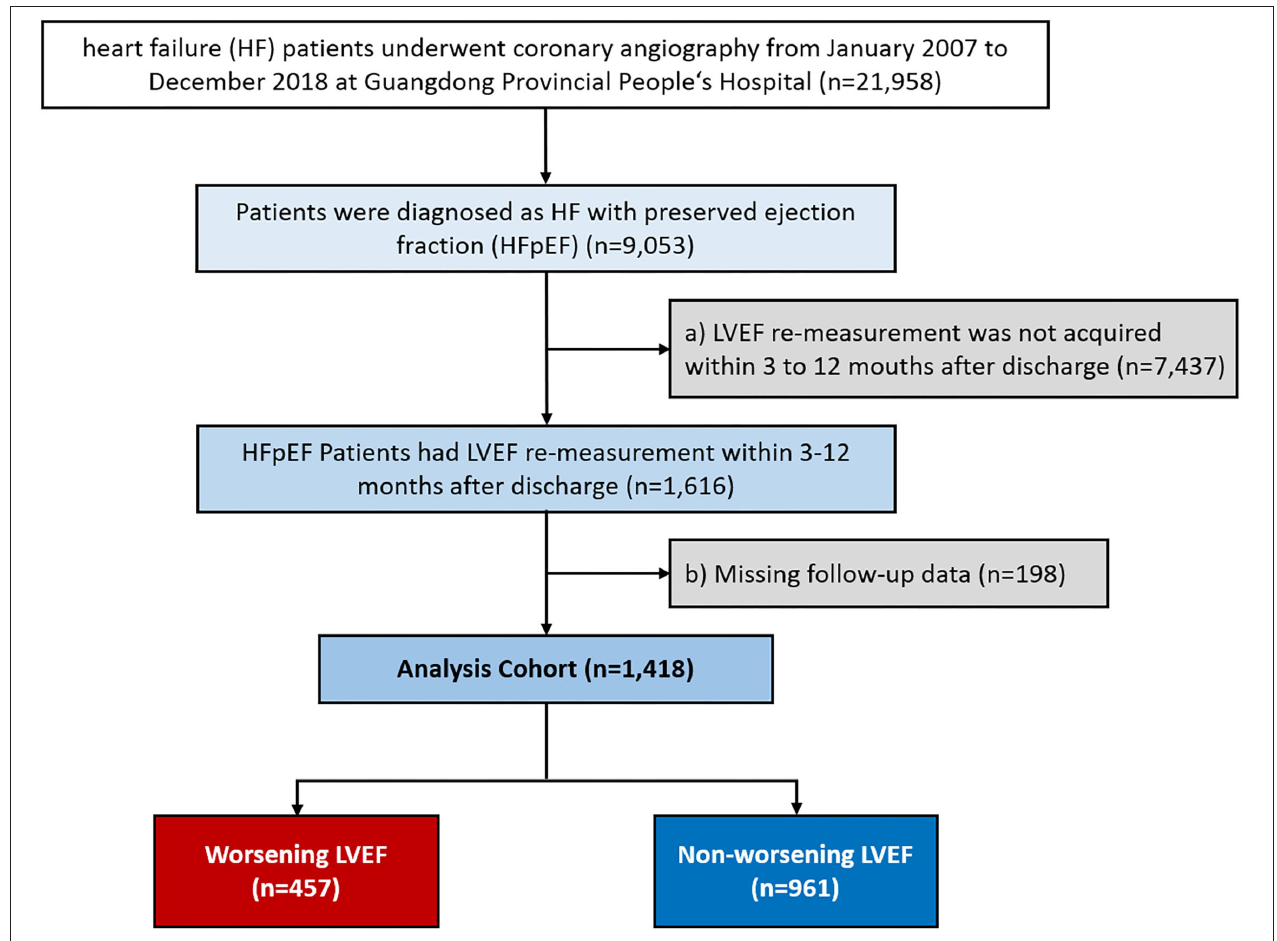
FIGURE 1 | Patient flow